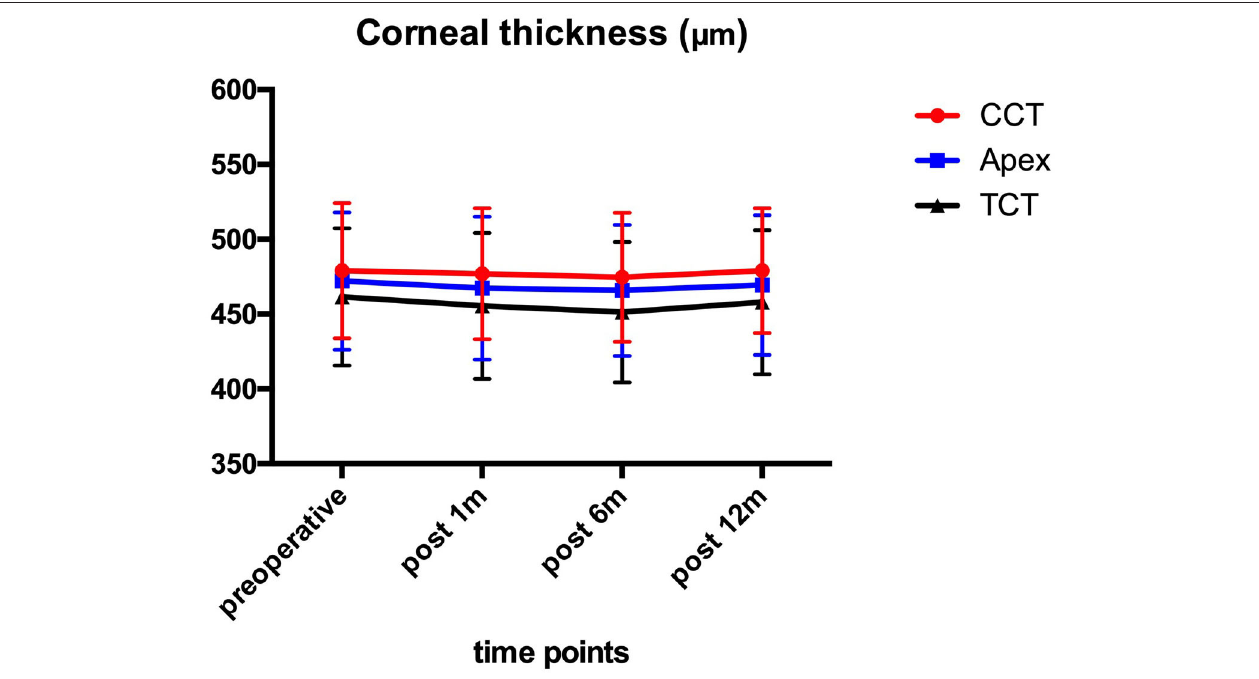
FIGURE 2 | CCT, TCT, and AT before and after ATE-CXL during 1-year follow-up. No significant ( P > 0.05) changes were found in CCT, TCT, and AT in comparison to preoperative values at each time point. (CCT, central corneal thickness; TCT, thinnest corneal thickness; AT, apex thickness; ATE-CXL, accelerated transepithelial corneal